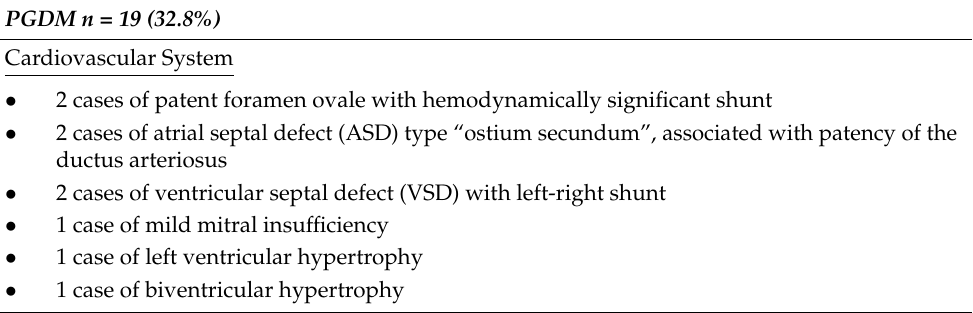
Table 3. Number of cases with morphological